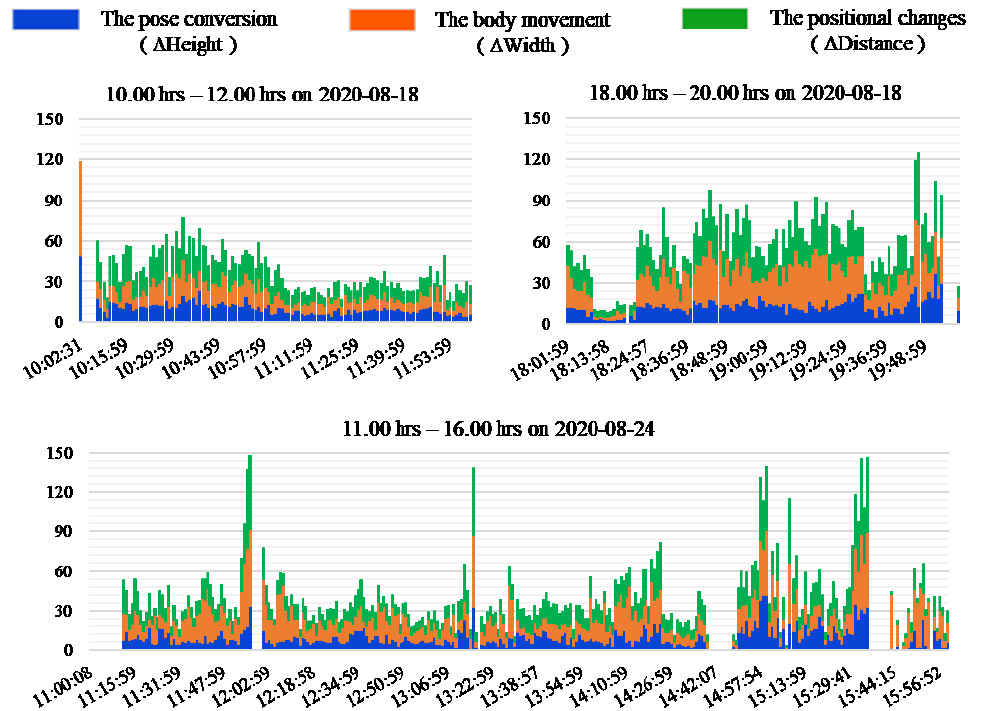
Figure 11. Example of the results with continuous postural changes in this